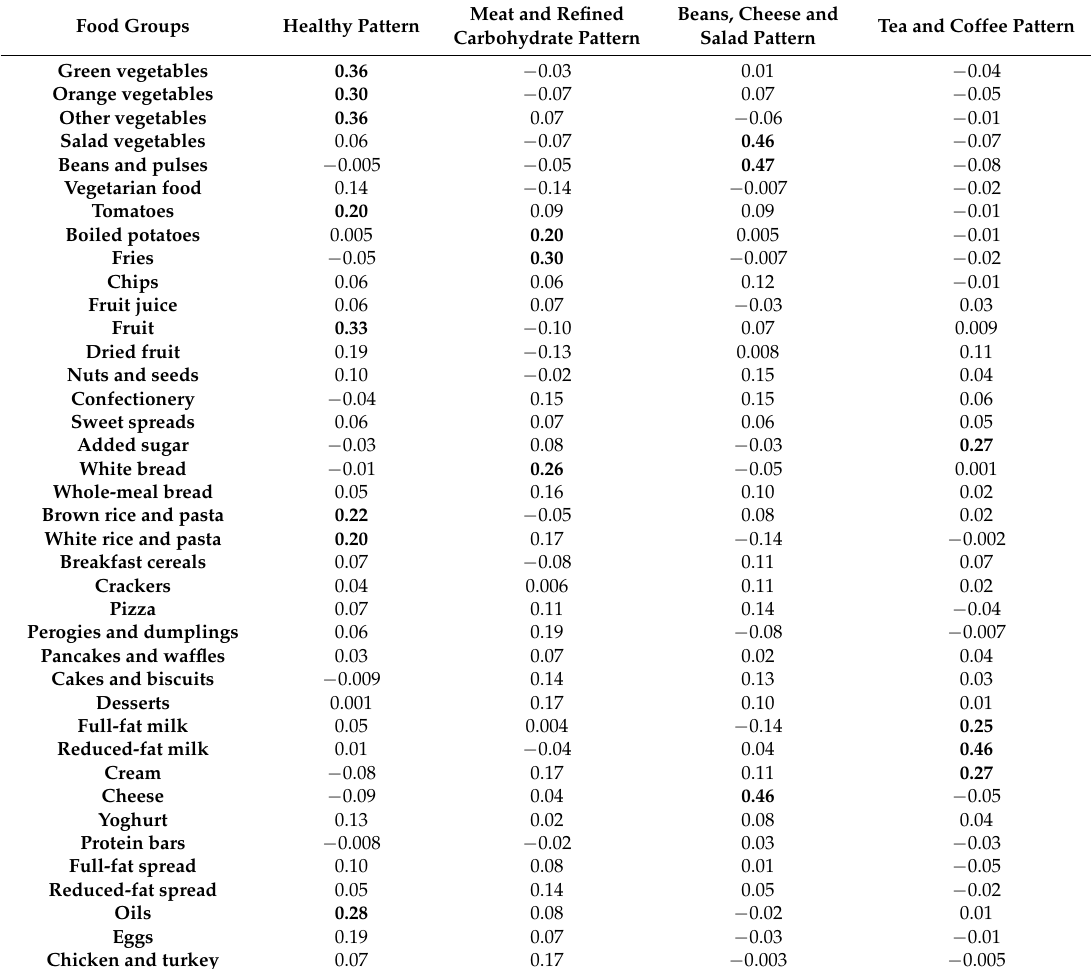
Table 2. Dietary patterns derived from principal component analysis and their corresponding coefficients. Food Groups Healthy Pattern